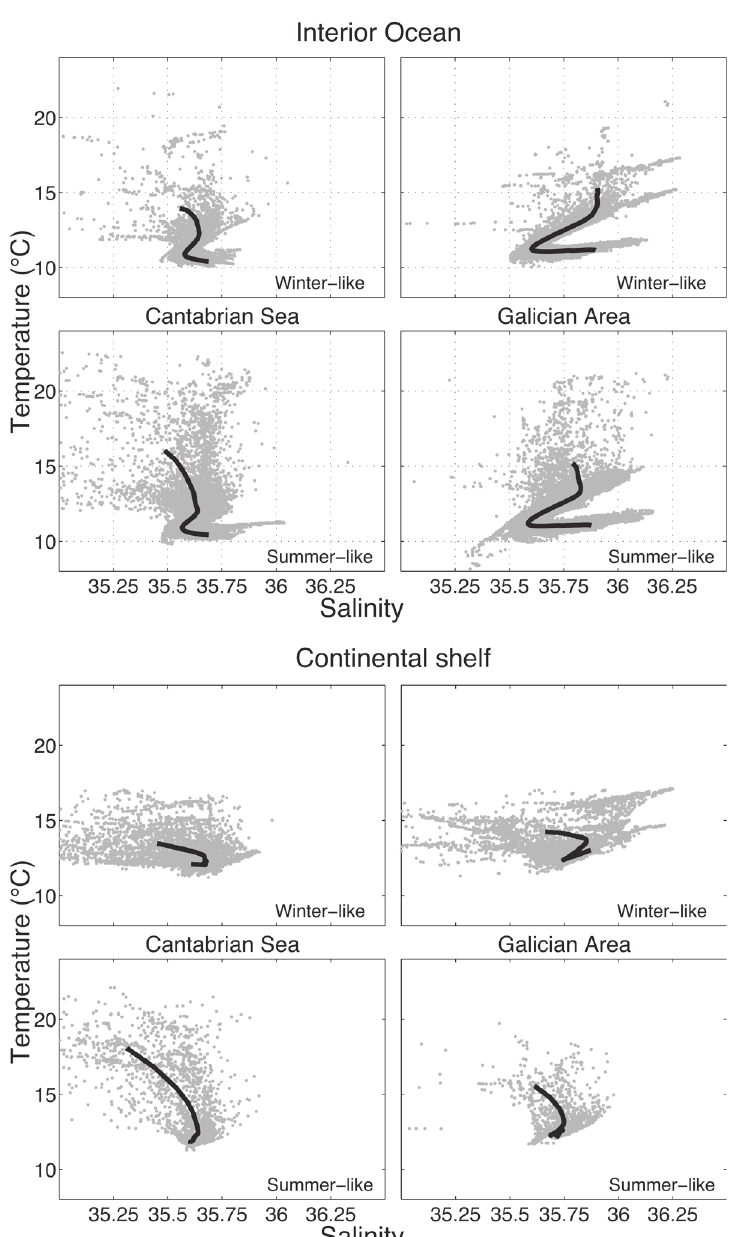
Fig . 7. – Upper: averaged temperature and salinity profiles for each region and temporal season in the interior ocean, as indicated in the text. Lower: same as before, but on the continental shelf. Gray dots represent the observations grouped for each